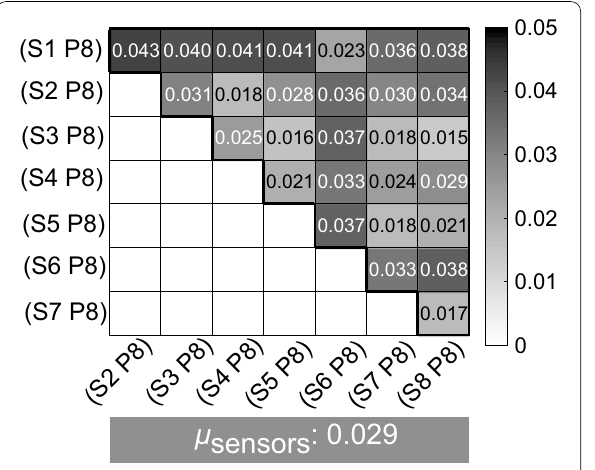
Fig. 7 Dissimilarity of different sensors